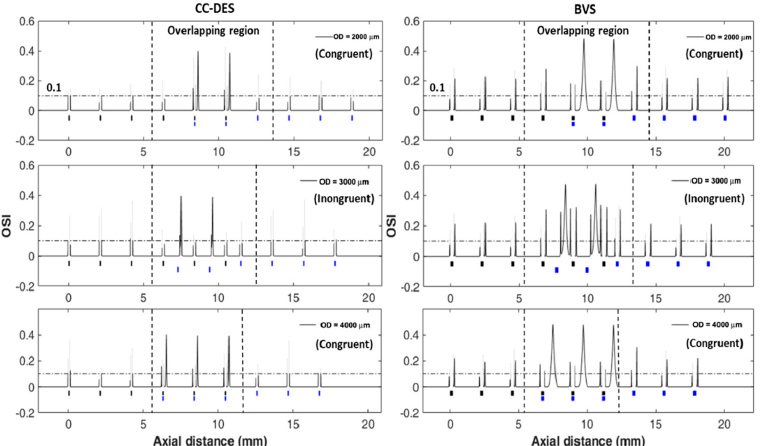
Figure 11. Oscillatory shear index (OSI) distribution for overlapping configuration. For simplicity reasons, three representative configurations are displayed for each strut size. Strut locations on the X-axis are indicated with black and blue rectangles. Notice that axial distance = 0 mm corresponds to the location of the first stent. Two ranges can be defined: OSI < 0.1 (Low recirculation) and OSI > 0.1 (High recirculation).